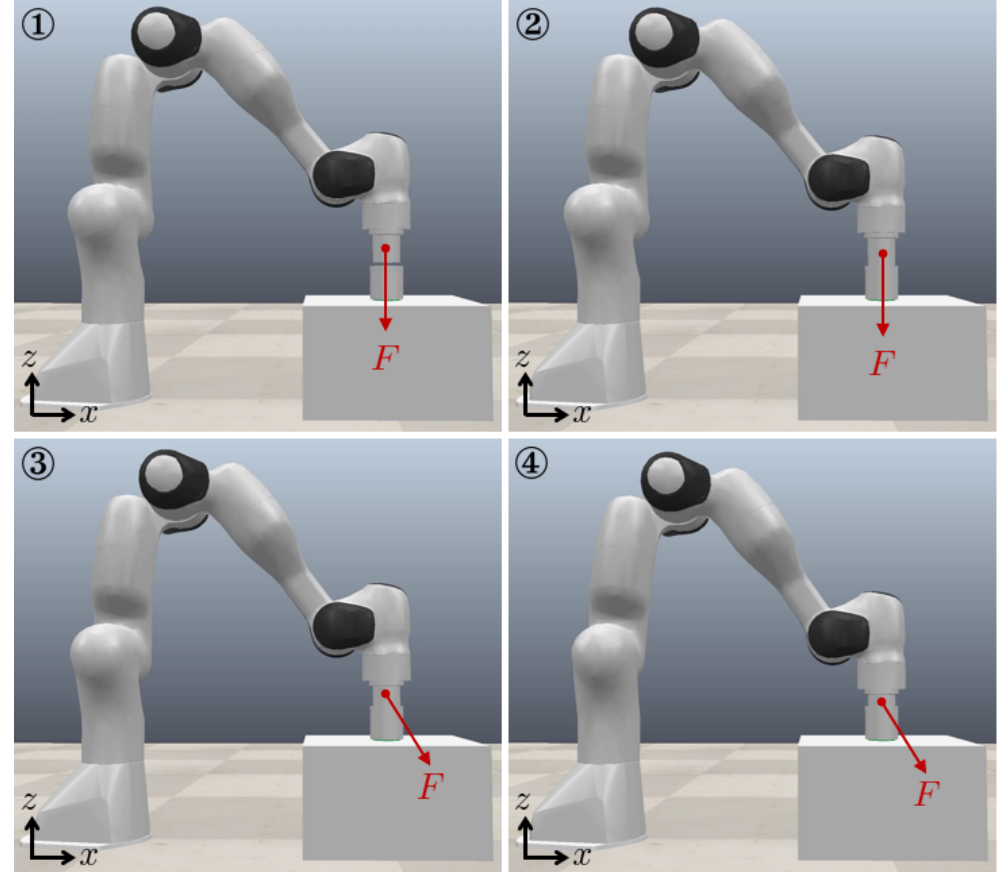
Figure 4. Snapshot of peg-in-hole scenario: the peg is first pressed down to insert the peg into the hole ( 1 , 2 ), and once the peg is in, it is pressed down and pushed in x direction to generate contact ( 3 , 4